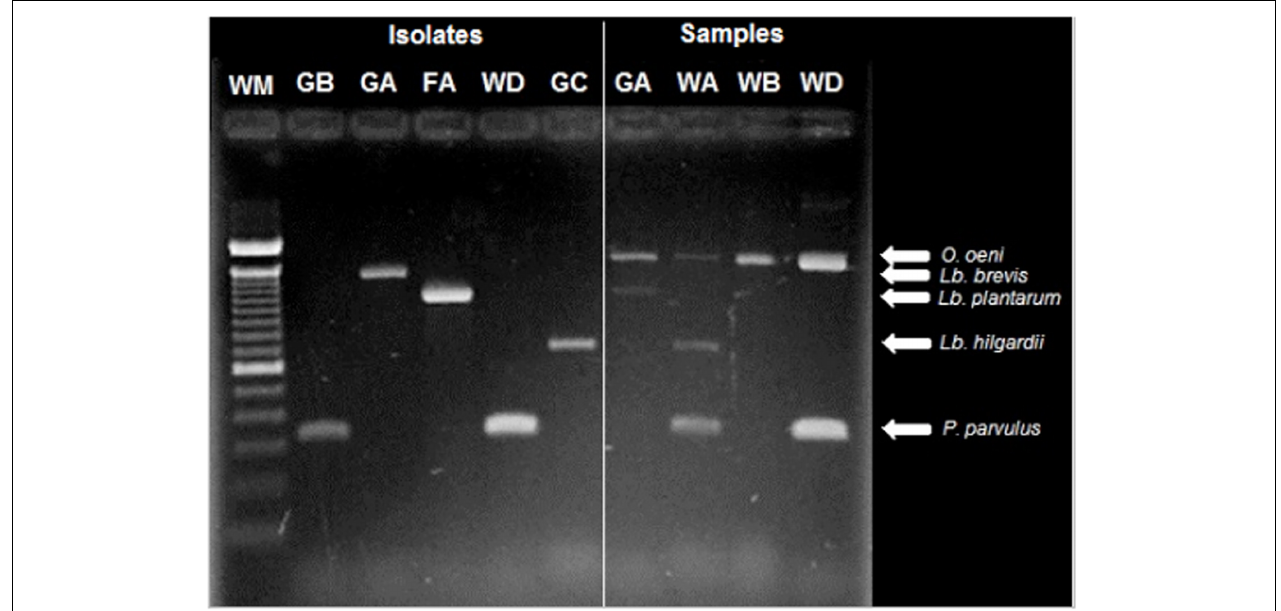
FIGURE 3 | Identification of LAB isolates (lines 2–5) and detection of species present in wine-related (6–9) samples using multiplex PCR. The origin of the sample is indicated above as follows: The first letter corresponds to the type of sample: G, must; F, banel/filter; W, wine. The second letter corresponds to the winery: A, B, C, or D. The first line corresponds to the molecular weight marker Trackit TM 100 bp (Invitrogen). Moreover, the species corresponding to that molecular weight is specified (Petri et al.,